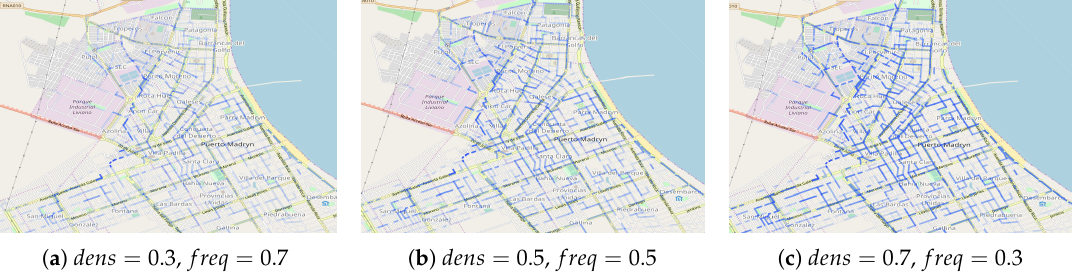
Figure 6. Full journey generation for different opacity